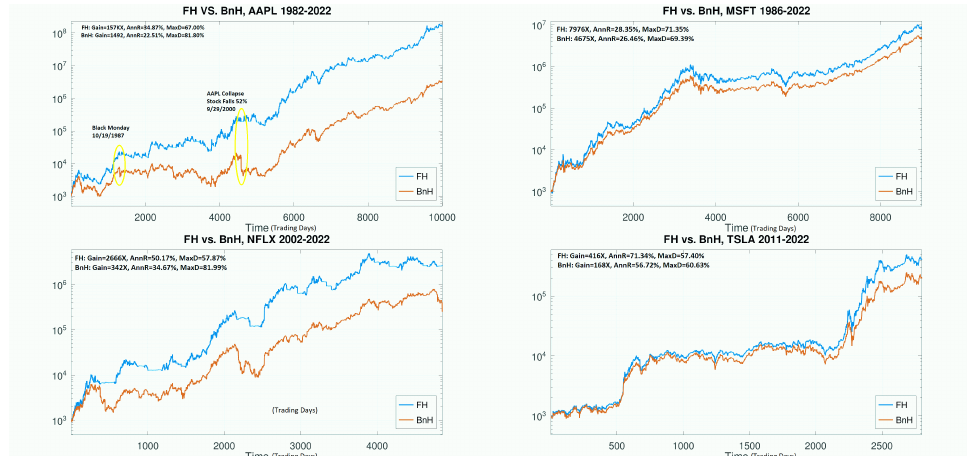
Figure 15. Performance of the FastHedge suite of algorithms on some popular stocks, AAPL, MSFT, NFLX, and TSLA, for available periods of time, showing that even the best of them can be improved, but some only